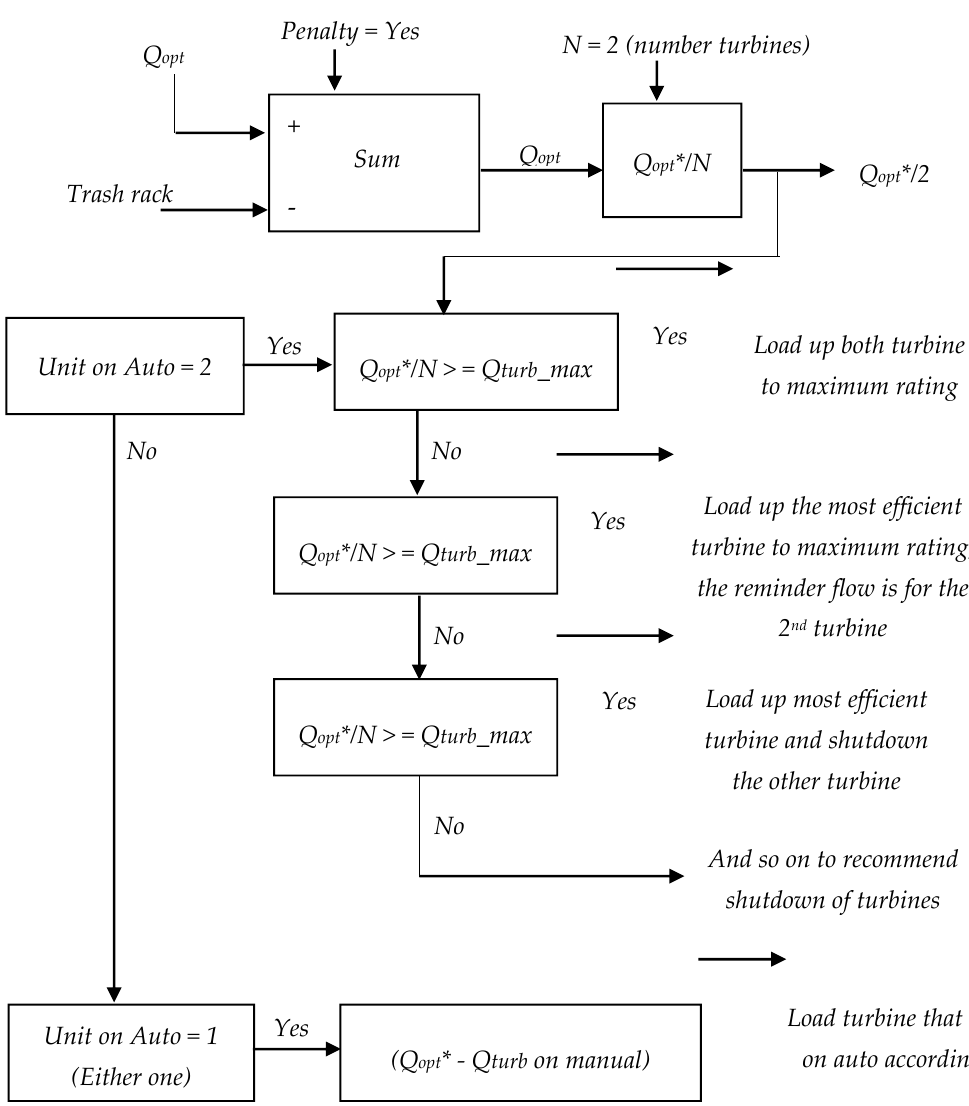
Figure 8. Discharge flow set point algorithm & simplified controller